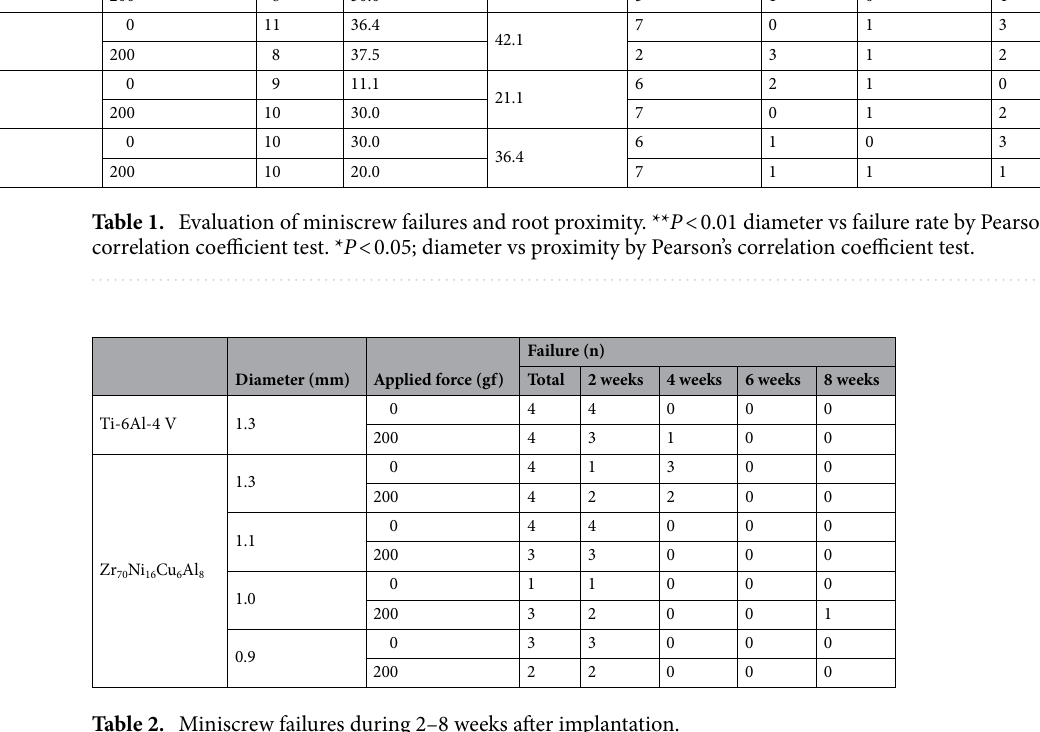
Table 2. Miniscrew failures during 2–8 weeks after implantation.